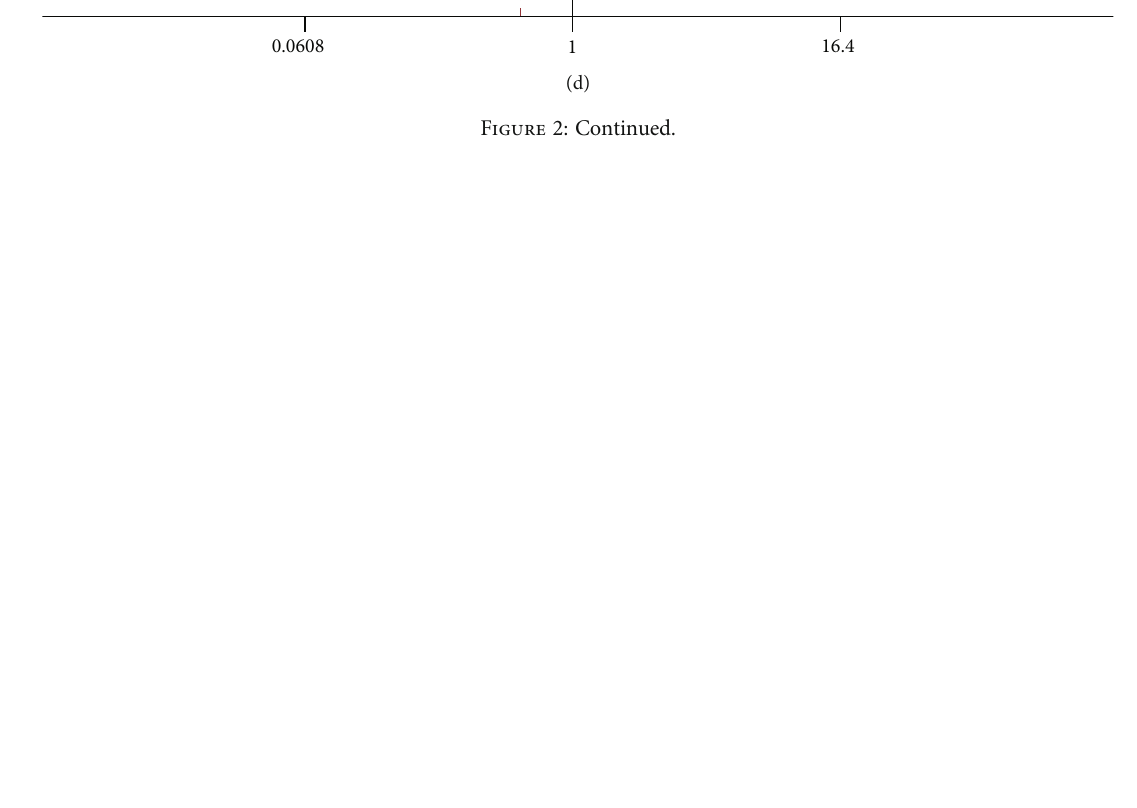
Overall (I-squared = 29.5%, p =